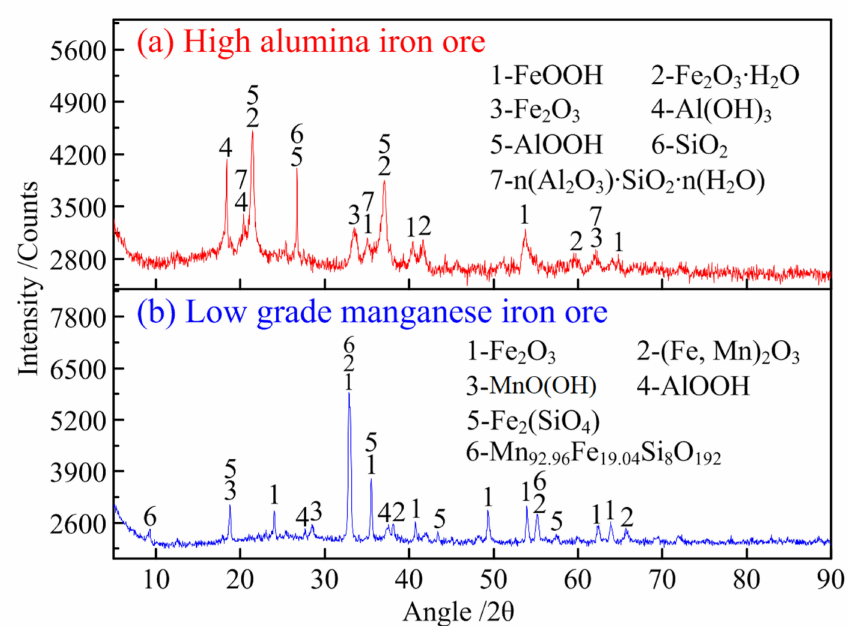
Figure 1. XRD patterns of Fe-Al ores and Fe-Mn ores; ( a ) the XRD pattern of High alumina iron ore and ( b ) the XRD pattern of Low grade manganese iron